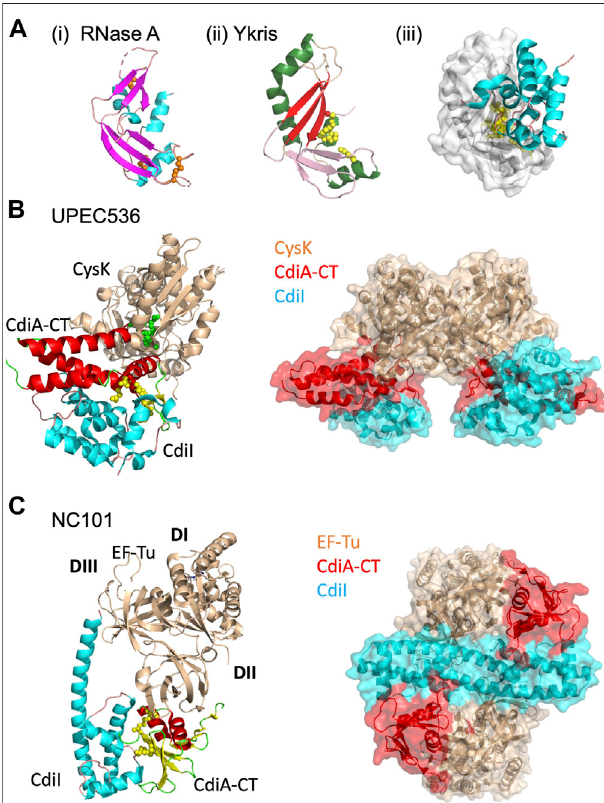
FIGURE4| CdiA-CTtoxinswithuniquecharacteristics. (A) Y.kristensenii (Ykris) [PDB ID: 5E3E (Batot et al., 2017)] has some structural homology to BECR family members, but most closely resembles RNase A [PDB ID: 4B36 (Thiyagarajan and Acharya, 2013)]. i) RNase A is shown in cartoon depiction with β -strands in magenta, α -helices in cyan, and loops in salmon, andwithconserveddisul fi debondsshown asorangespheres.ii)CdiA-CT Ykris in cartoon representation with its BECR core structure colored by as in Figure 2 left panels. iii) The CdiA-CT/CdiI Ykris complex with CdiI colored as in Figure2 rightpanels.In (B,C) theaccessoryprotein(CysKorEF-Tu)isshown in beige, while on the left the toxin and immunity protein are colored by secondary structure where CdiA-CT has β -strands in yellow, α -helices in red, and loops in green; CdiI has α -helices in cyan and loops in pink. Active site residues for CdiA-CT are shown as yellow spheres. In the complex on the right, CdiA-CT is colored red, CdiI cyan and the accessory protein is in beige. (B) InUPEC536,CdiA-CTformsacomplexwithCdiIandCysK[PDBID:5J5V (Johnson et al., 2016a)]. The C-terminal residue of CdiA-CT (green spheres) that inserts into the CysK active site is highlighted. Shown on the right is the overall oligomerization of the CdiA-CT/CdiI/CysK complex, where CysK dimerization results in a dimer of heterotrimers. (C) In E. coli NC101, CdiA-CT interactsdirectlywithCdiIanddomain2(DII)ofEF-Tu,whileCdiIinteractswith DII and domain 3 (DIII) of EF-Tu (PDB ID: 5I4R; (Jones et al., 2017). On the right, the CdiA-CT/CdiI/EF-Tu complex isshown, whereCdiI forms the center of the dimer of